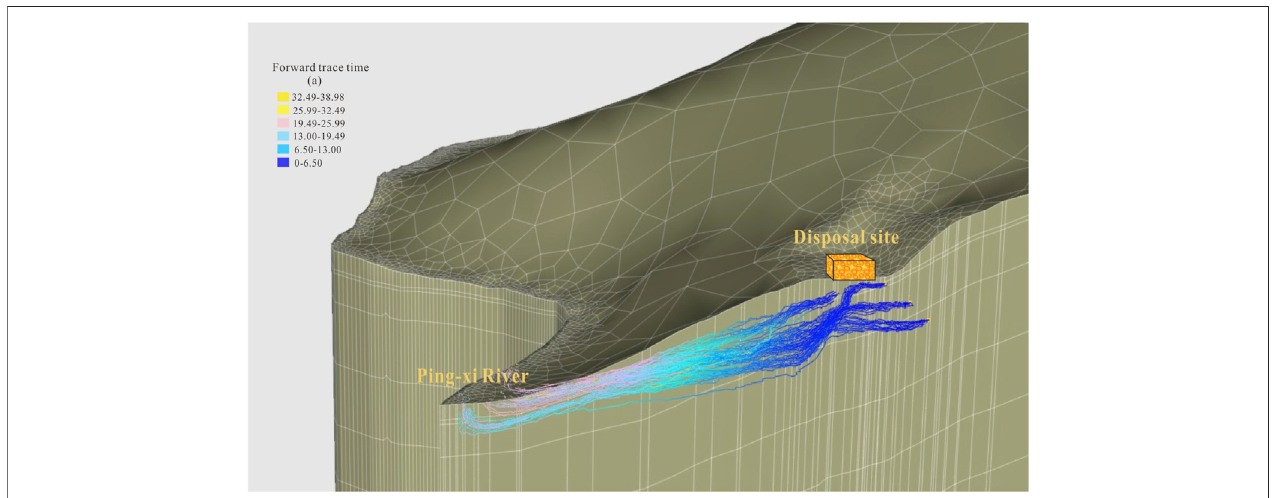
FIGURE 9 | Particles ’ travel lines from the aquifer beneath the repository to the Pingxi